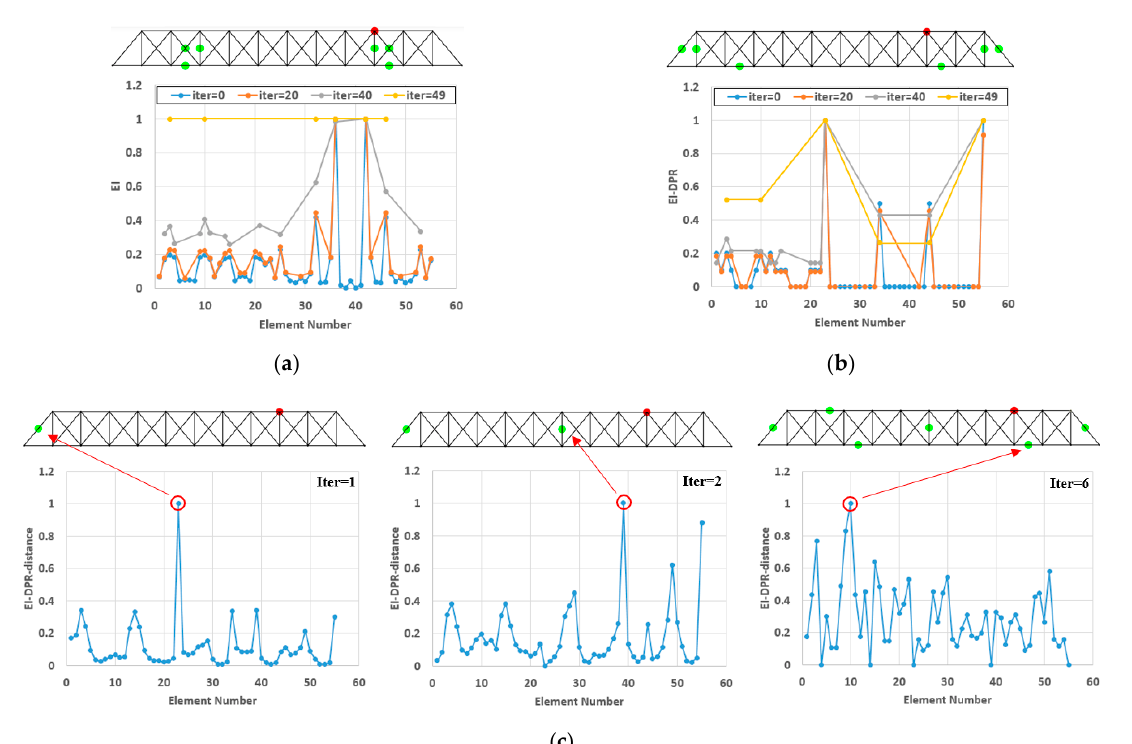
Figure 15. Procedure example of each sensor placement method (Case 2: strain with one displacement): ( a ) EI method, ( b ) EI-DPR method, ( c ) EI-DPR-distance method.